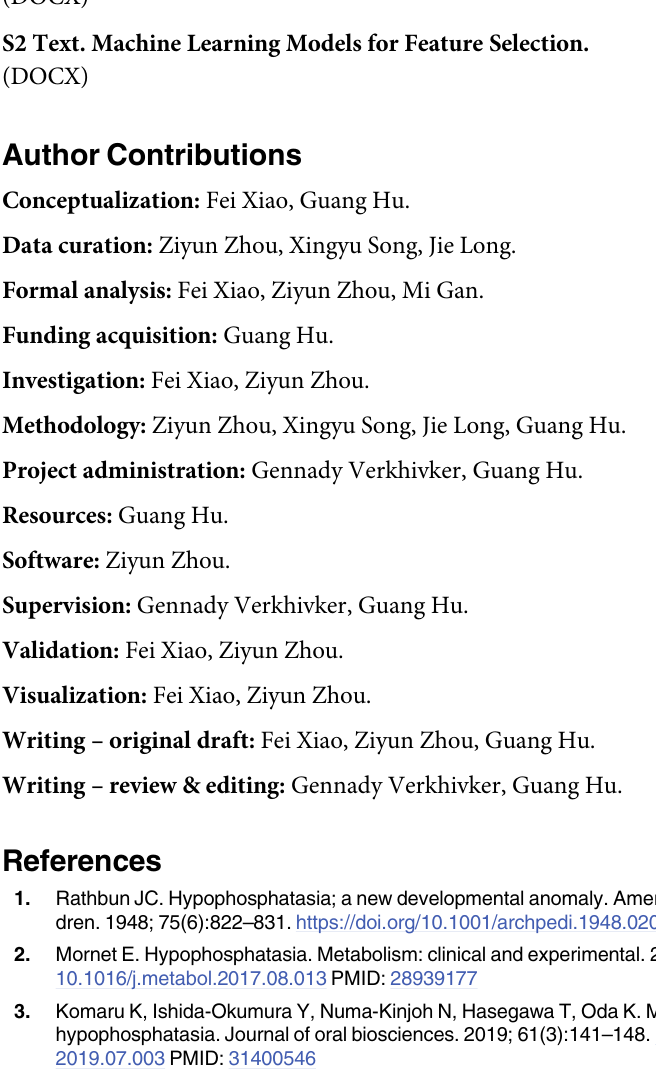
and M355I (B) mutant. The green and grey line shown the BC values of residues of DRN and AACEN. If the residues corresponding to the peaks of DRN BC has the mild and severe muta- tions we collected, it is highlighted as yellow and red diamonds, respectively. DRNs can cap- ture more peaks that correspond to disease mutations, such as T68M, T165I and I395V (mild mutations) and G334D (severe mutations) in L289F mutant, while T68M, V95M, T165I, D378V and L414M (mild mutations) and D378V (severe mutations) in M355I mutant. (TIF) S8 Fig. Graphical comparison of ΔΔ G (the green line) and Δ g (the orange line) for the choose severe mutations. (TIF) S1 Table. Collected mutation data of three kinds of phenotypes, with their structural domain annotation and various computational molecular signatures. (XLSX) S1 Text. Sequence and Structural Landscape of ALPL mutations. (DOCX) S2 Text. Machine Learning Models for Feature